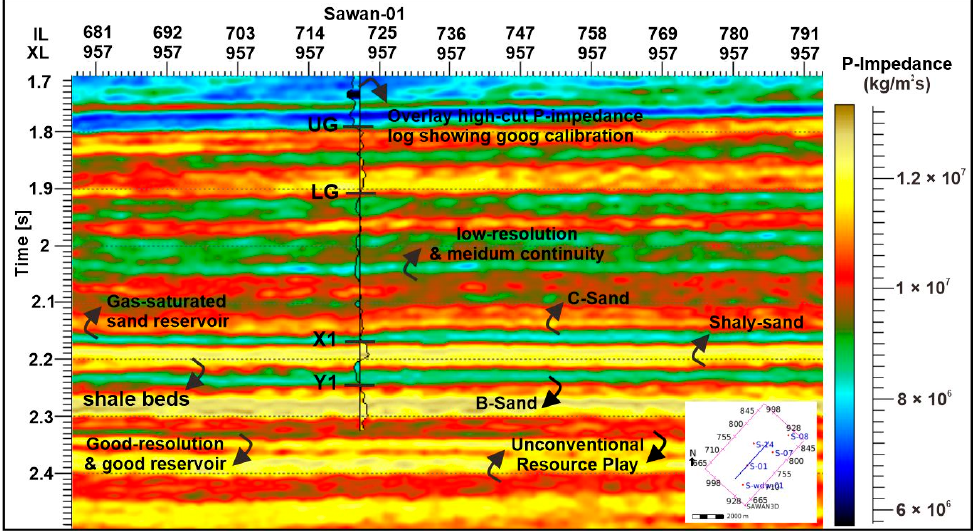
Figure 10. Overly of p-impedance log on inverted AI section at S-01 well and crossline-957 location.